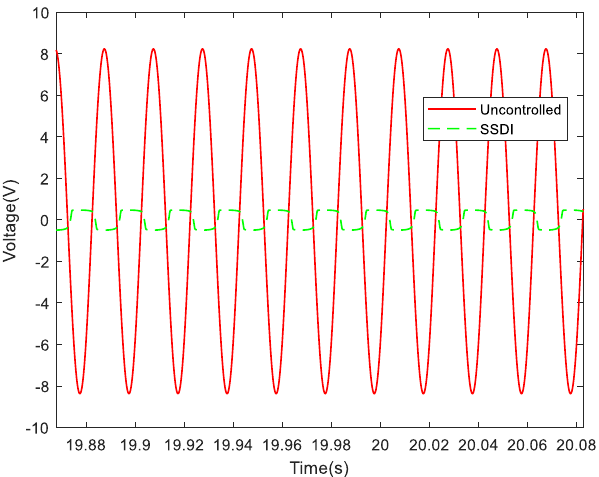
Figure 20. Evolution of the voltages on PZT1 with and without SSDI (50 Hz).